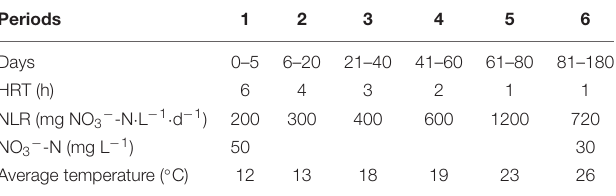
TABLE 1 | Influent conditions of the R 1 –R 4 reactors in periods 1–6.